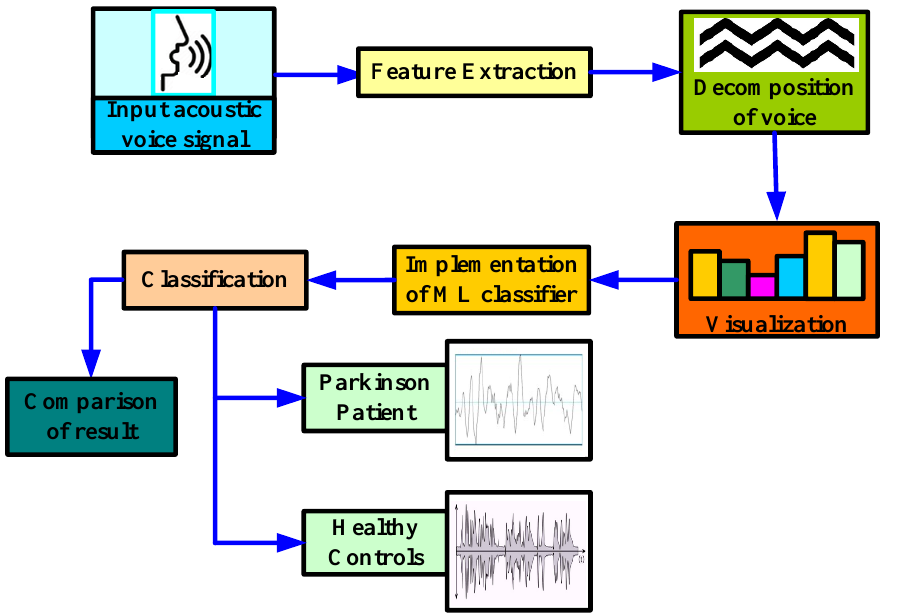
Figure 5. Proposed methodology to diagnose Parkinson’s disease by [87].